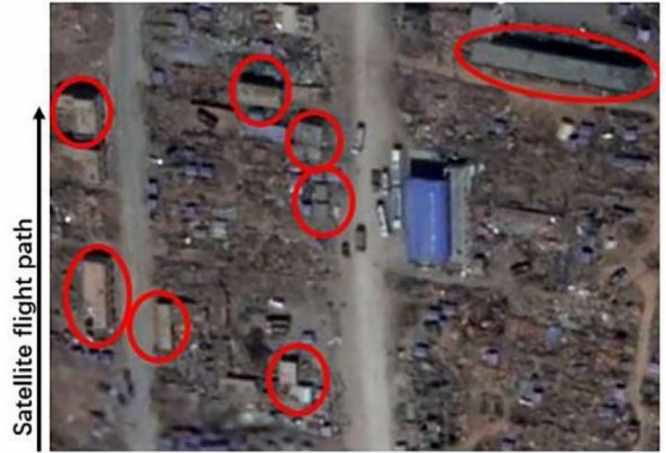
Figure 18. The optical images (data source: Google earth) of the special seriously damaged areas with a few typical orthogonally-oriented buildings (red